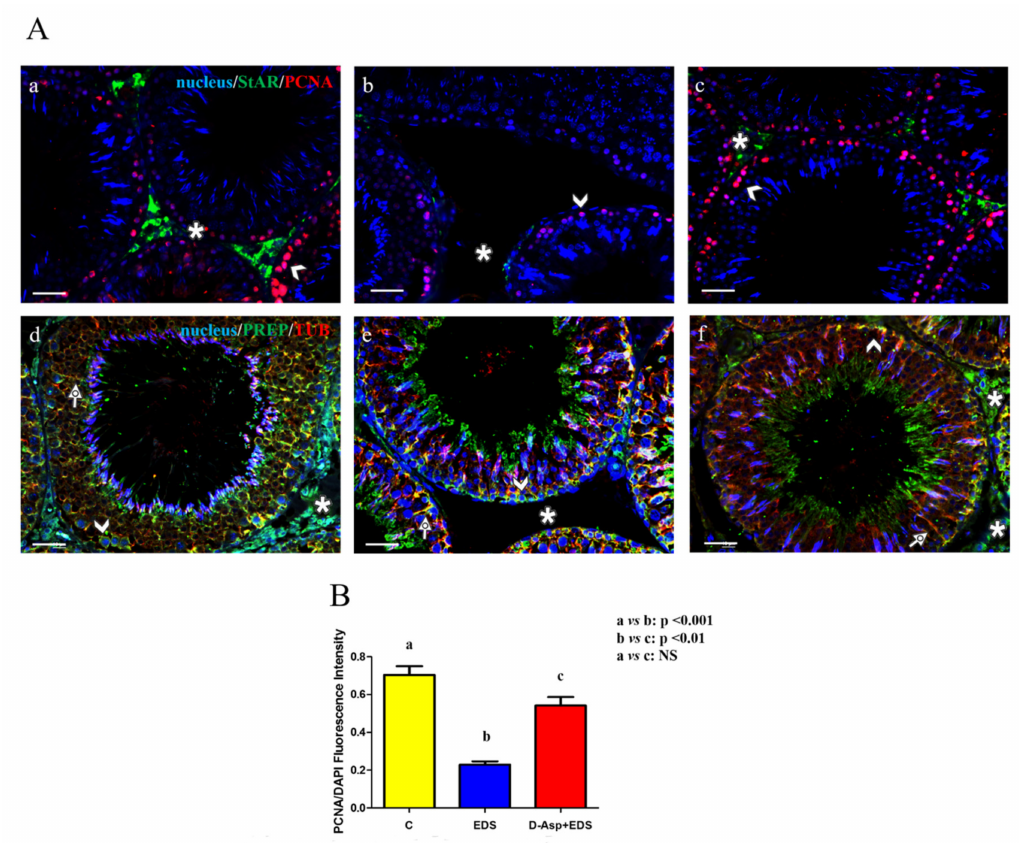
Figure 4. ( A ) StAR-PCNA and PREP-TUB co-localization in the testis from controls, EDS, and D-Asp + EDS treated rats. a-c: StAR (green) and PCNA (red) immunolocalization in the testis of control ( a ), EDS ( b ) and D-Asp + EDS ( c ) treated rats. d-e: PREP (green) and tubulin (red) immunolocalization in the testis of control ( d ), EDS ( e ), and D-Asp + EDS ( f ) treated rats. The yellow-orange intermediate tint indicates the two proteins co-localization. Slides were counterstained with DAPI-fluorescent nuclear staining (blue). The images were captured at × 20 magnification. Scale bars represent 20 µ m. Asterisks: Leydig cells. Arrowheads: Spermatogonia; Arrows: Sertoli cells cytoplasm. ( B ) Histogram showing the quantification of PCNA fluorescence signal intensity using ImageJ. Values are expressed as means ± SEM from 5 animals in each